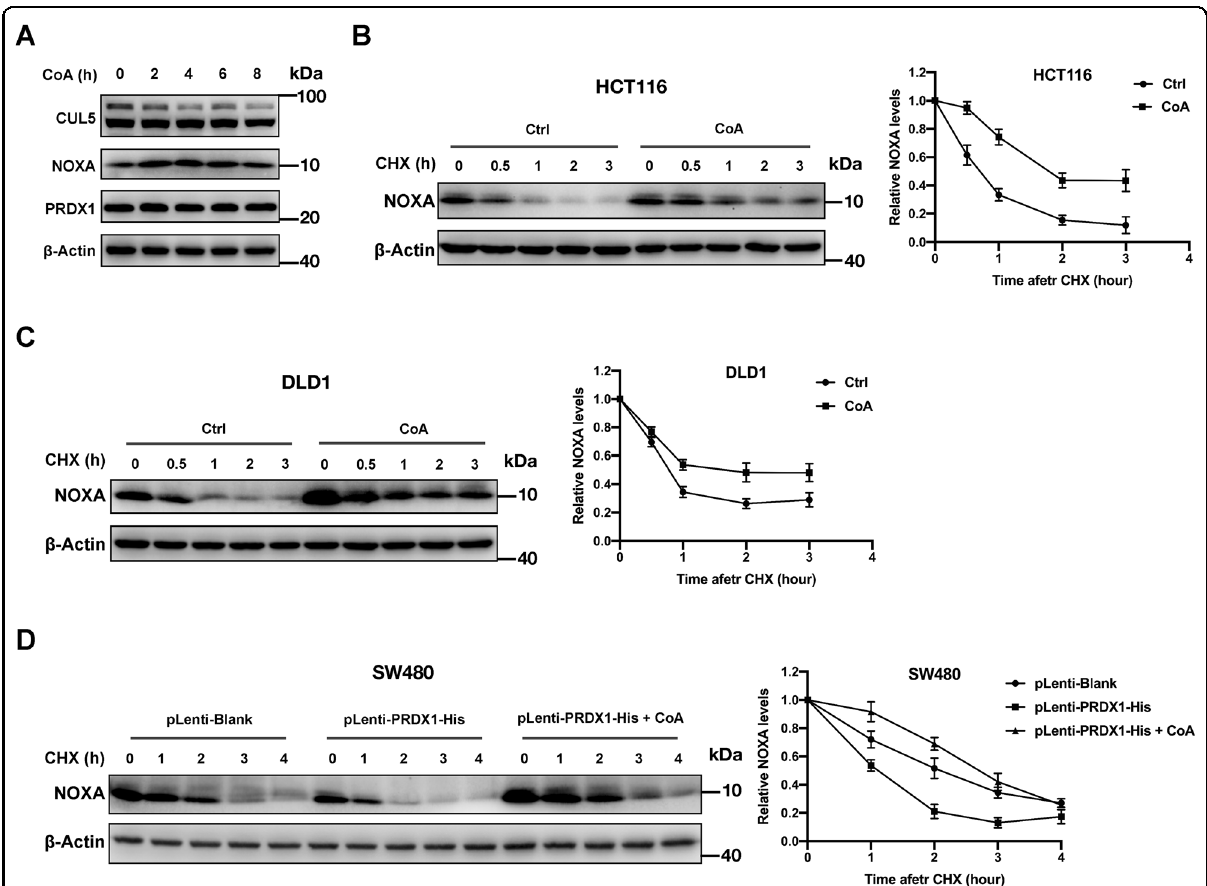
Fig. 5 Oligomerization of PRDX1 is required for CUL5 neddylation and NOXA degradation. A WB analysis of PRDX1, CUL5 neddylation and NOXA protein levels in HCT116 cells treated with CoA (10 μ M) for 0~8 h. HCT116 cells treated with CoA for a fi xed time were lysed with RIPA buffer before WB analyses. B – D Analysis of the in fl uence of the PRDX1 oligomerization inhibitor CoA on the degradation rate of NOXA: HCT116 ( B ), DLD1 ( C ) and transduced SW480 ( D ) cells in 6-well plates were pretreated with CoA (10 μ M) for 2 h prior to CHX treatment for a fi xed duration before being lysed for WB analysis. The results are representative of three independent experiments, and band densities were quanti fi ed using Image Lab software and plotted using Prism 8 software (mean ±